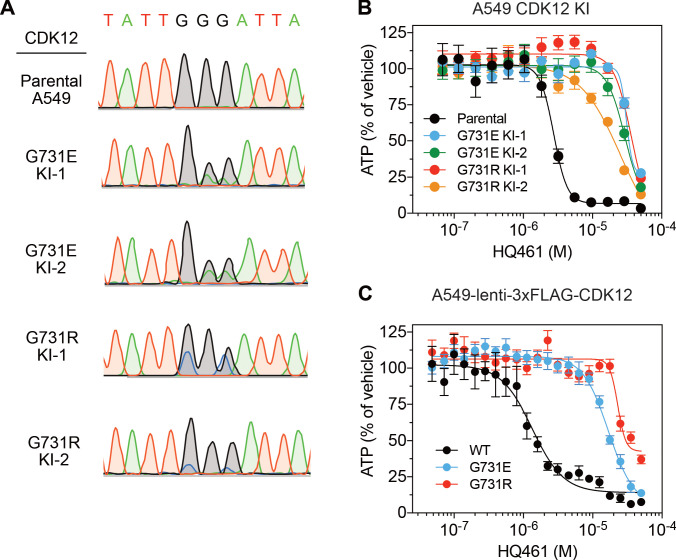
The CDK12 G731E and G731R mutations confer HQ461 resistance.(A) Sanger sequencing verification of GGG to GAA and GGG to CGC mutations introduced by CRISPR-Cas9-mediated homology-dependent repair in A549 cells. (B) Measurement of the HQ461 IC50 on the viability of CDK12 G731E or G731R knock-in A549 cells (IC50 ranging from 25.2 µM to 36.5 µM). Error bars represent SEM from three biological replicates. (C) Measurement of the HQ461 IC50 on the viability of A549 cells stably expressing wild-type (IC50 = 1.3 µM, 95% CI: 1.1 µM-1.7 µM) or G731E/R mutant CDK12 (G731E IC50 = 16.9 µM, 95% CI: 14.2 µM-20.2 µM; G731R IC50 = 22.9 µM, 95% CI: 19.7 µM-26.8 µM). Error bars represent SEM from three biological replicates.